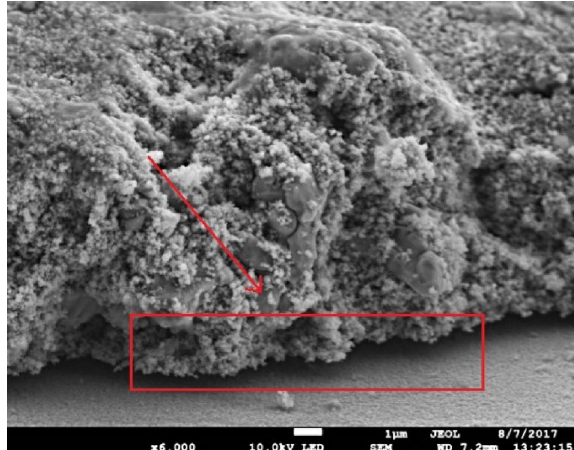
Figure 8. FTO—100 N Interface when photonically